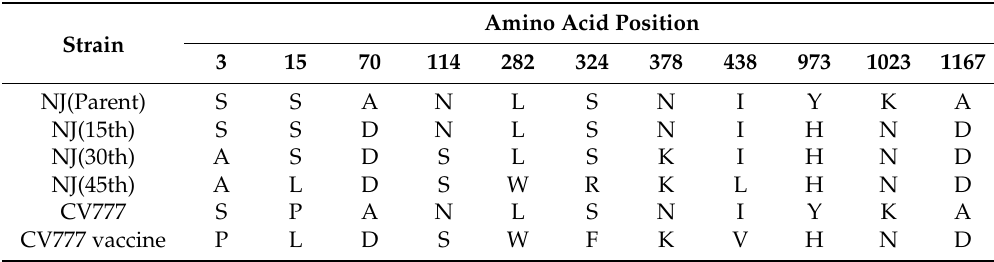
Table.2. The amino acid variation of S proteins during the serial passaging compared with CV777 and its vaccine strain.